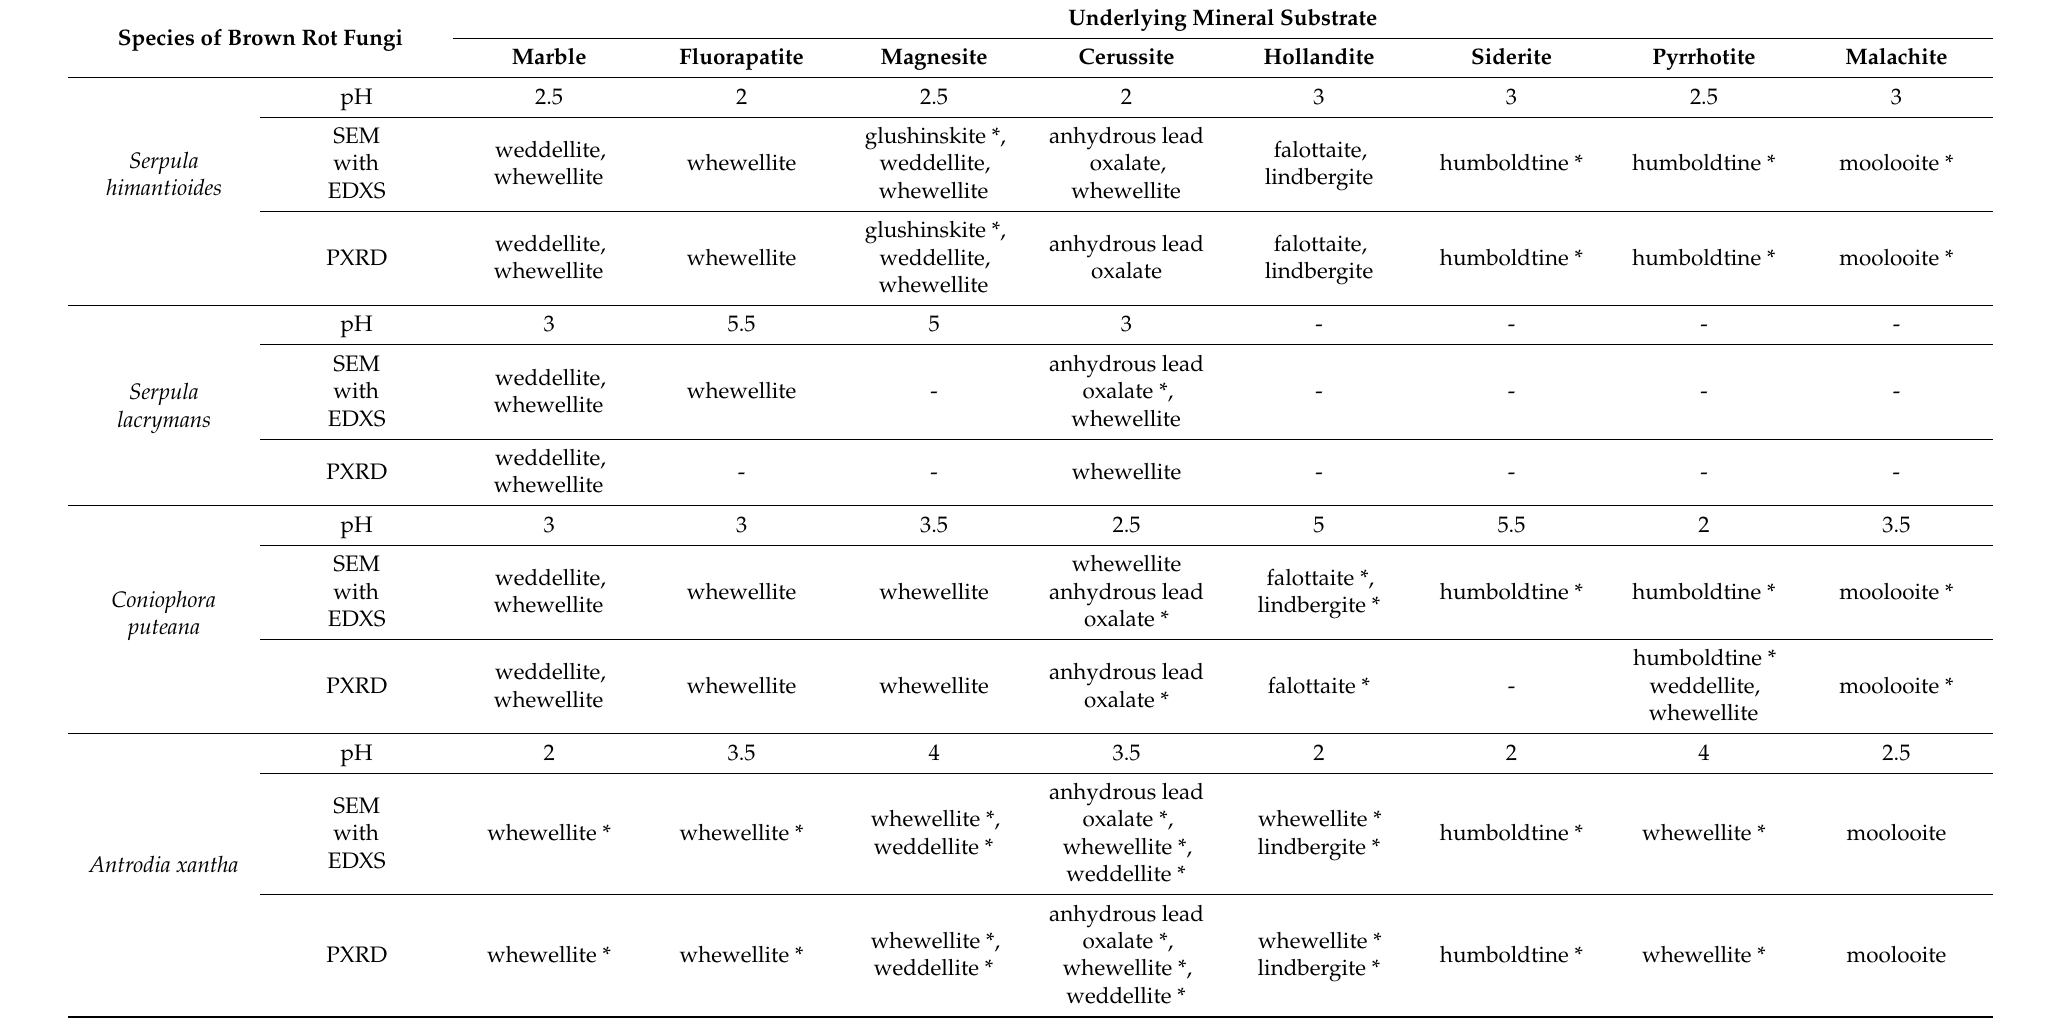
Table 4. The crystalline products of the reaction between mineral substrates with four species of brown rot fungi vs. pH of crystallization medium (SEM and PXRD). Species of Brown Rot